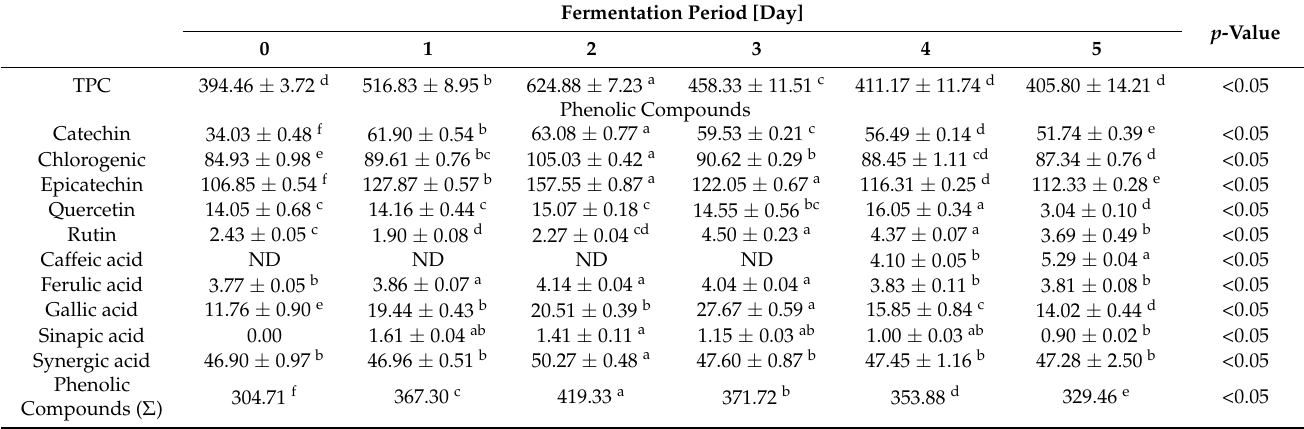
Table 4. Evaluation of total phenolic content (TPC, mg GAE/100 g) and phenolic compounds (mg/100 g) during water kefir-assisted fermentation of lentil–casein protein complex at a ratio of 1.0:0.1 (LCPC